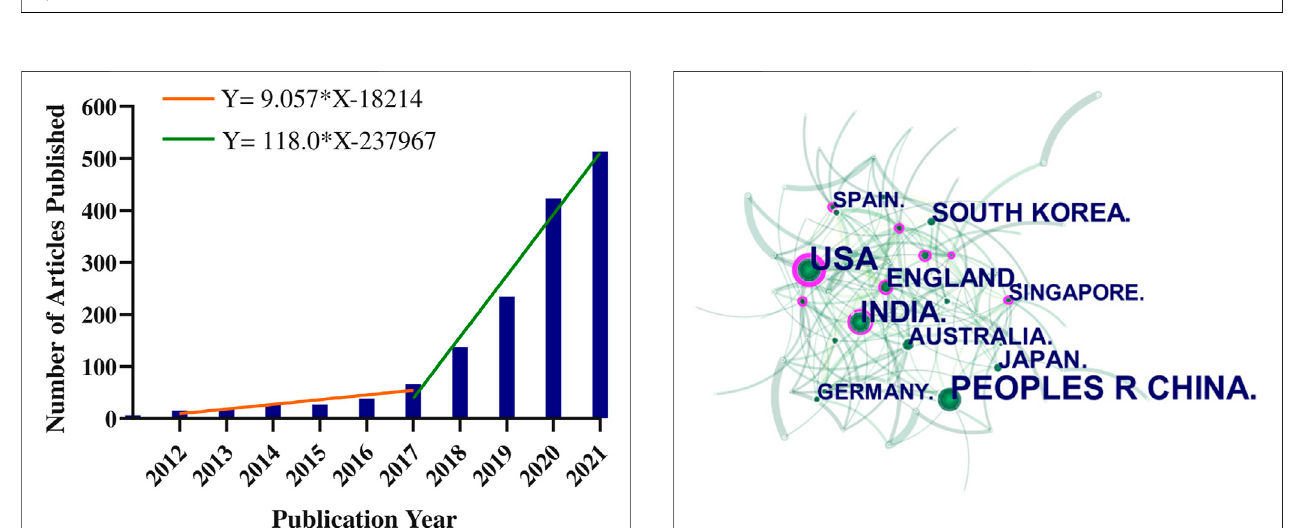
FIGURE 3 | Cooperation of countries or regions that contributed to publications on the use of AI for the diagnosis of ophthalmic diseases from 2012 to